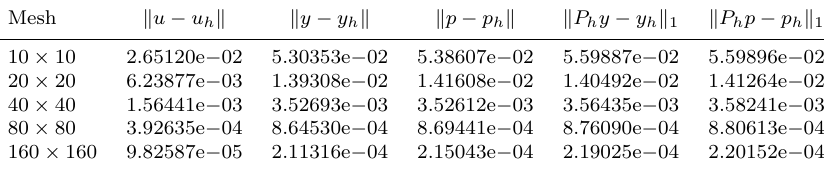
Table 2. Numerical results, Example